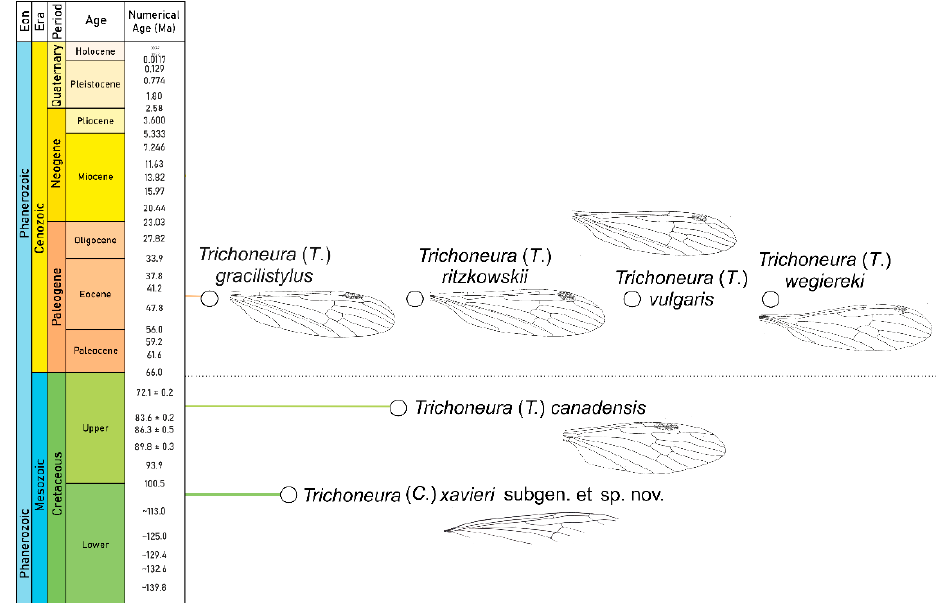
Figure 4. Chronostratigraphic distribution of Trichoneura , fossil species , redrawn after [1,6–9]. Chronostratigraphic chart and the colors of the lines that indicate age of extinct species of Trichoneura are used according to International Chronostratigraphic Chart v.2020.03 (https://stratigraphy.org/chart) (accessed on 29 April 2021).